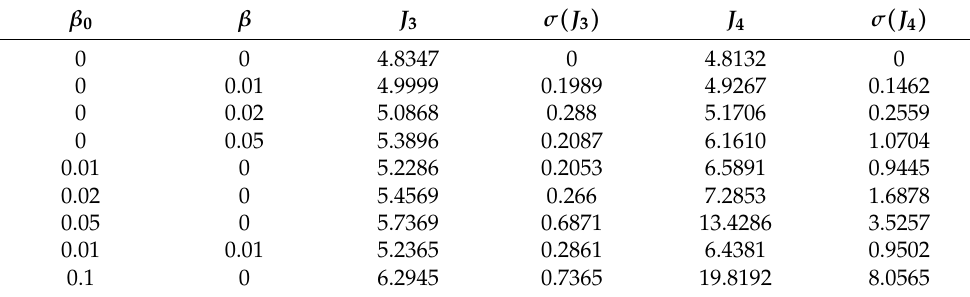
Table 1. Functional values for perturbed control object model.